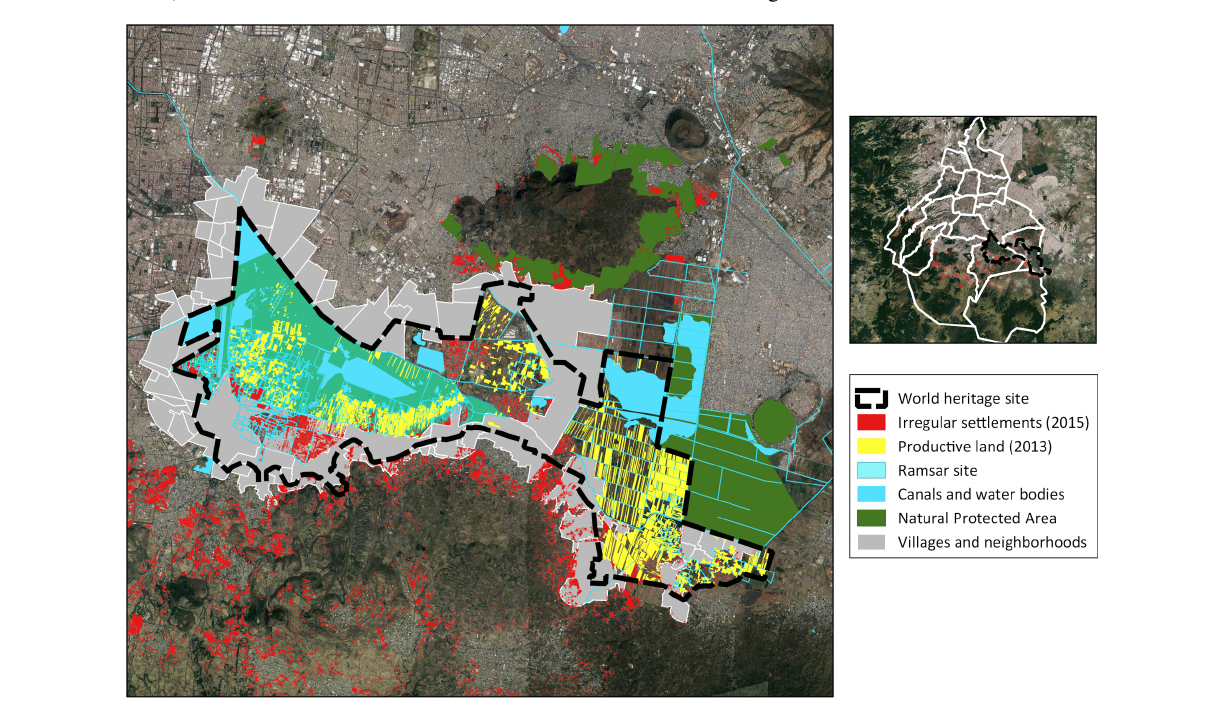
Fig. 1 . The Xochimilco urban wetland system. Map developed by LANCIS Collaborative Planning Lab (N. Ruiz, E. Villa Mendoza, and C. Cantero) with data provided by the Autoridad de la Zona Patrimonio Mundial Natural y Cultural de la Humanidad en Xochimilco, Tláhuac y Milpa Alta from 2013, and the Secretaria del Medio Ambiente from 2015 for the irregular